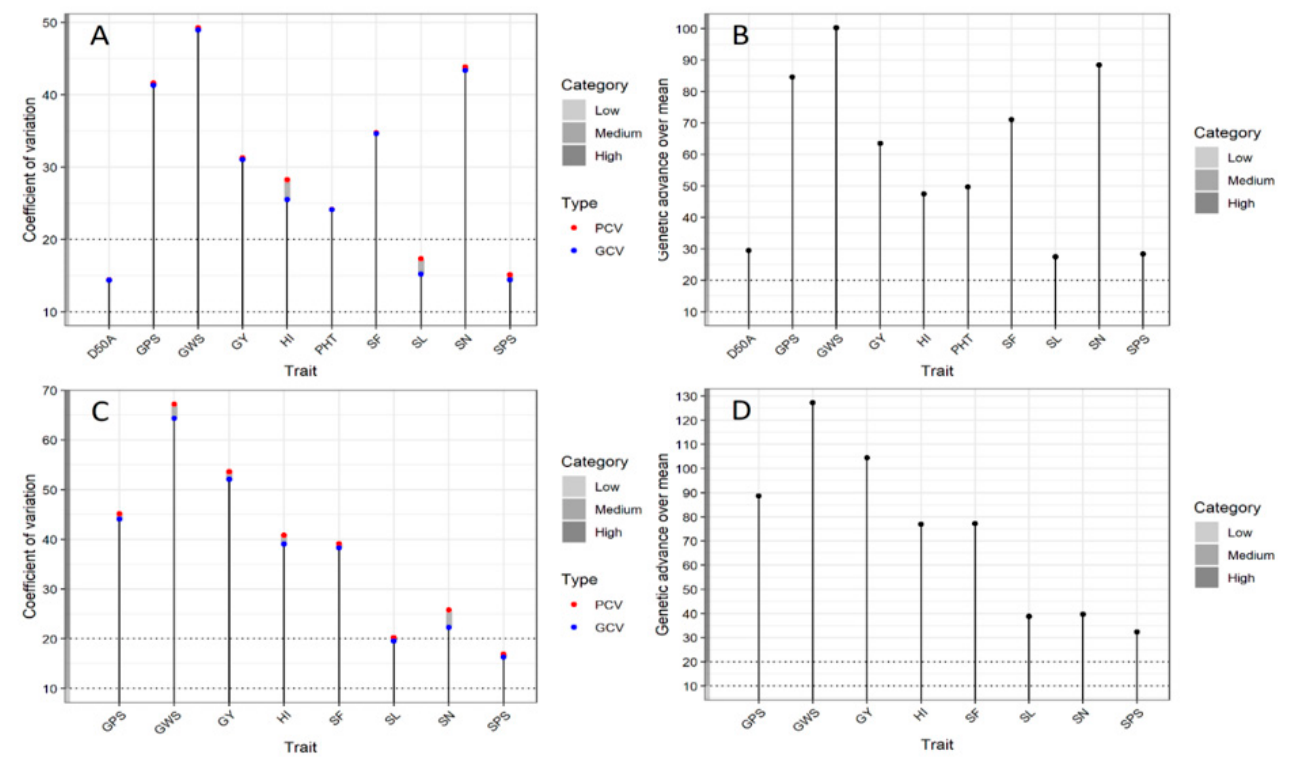
Figure 3 . Phenotypic and genotypic coefficient of variability analysis for various agronomic traits of 46 wheat genotypes grown under drought ( A , B ) and heat-stressed ( C , D ) conditions. Abbreviations are: days to 50% anthesis (D50A); grains per spike (GPS); grains weight per spike (GWS); grains yield (GY); harvest index (HI); plant height (PHT); spike fertility (SF); spike length (SL); spike number per genotype (SN); spikelets per spike (SPS).